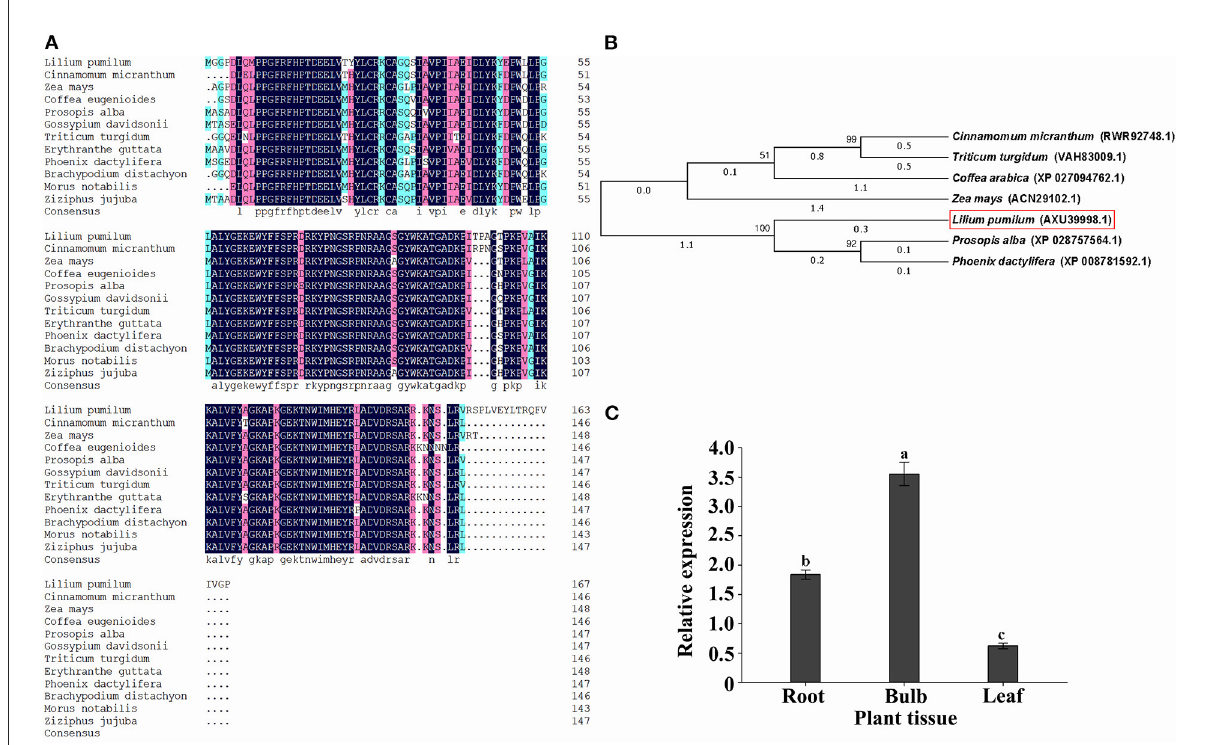
FIGURE1 Sequence and expression analysis of LpNAC17 . (A) Multiple sequence alignment of the deduced amino acid sequences of LpNAC17 from L. pumilum with other NACs from Cinnamomum micranthum (RWR92746.1), Zea mays (ACN29102.1), Coffea eugenioides (XP_027148352.1), Prosopis alba (XP_028757564.1), Gossypium davidsonii (MBA0625903.1), Triticum turgidum (VAH67189.1), Erythranthe guttata (XP_012844117.1), Phoenix dactylifera (XP_008781592.1), Brachypodium distachyon (XP_003564785.1), Morus notabilis (XP_010095416.1), Ziziphus jujuba (XP_015885739.1). (B) Phylogenetic tree of LpNAC17 and its homologs. (C) Expression analysis of LpNAC17 gene in different tissues of L. pumilum . LilyActin was used as the internal control gene. Bars represent the SE of three independent experiments and the different letters indicate the significant difference at P <